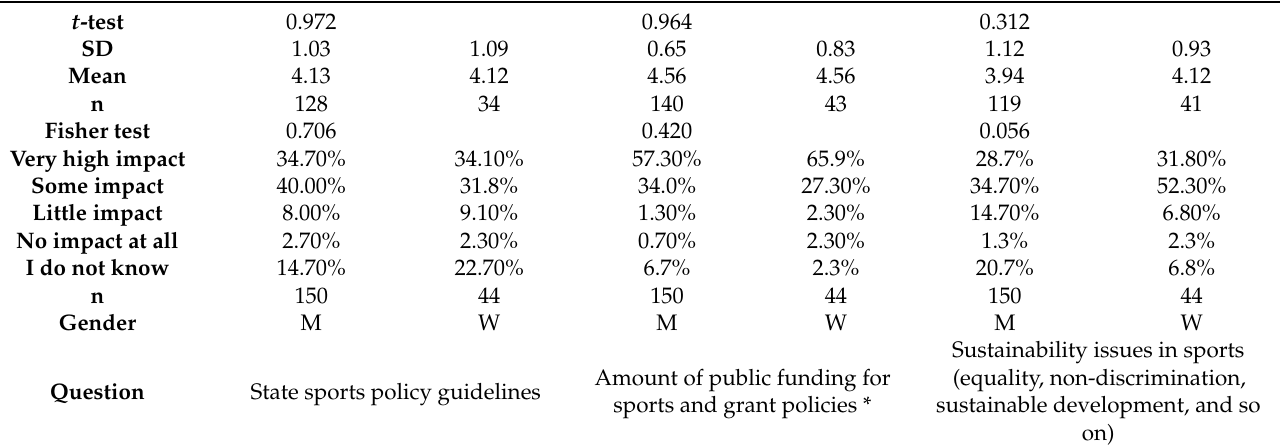
Table 5. Impact on future strategic